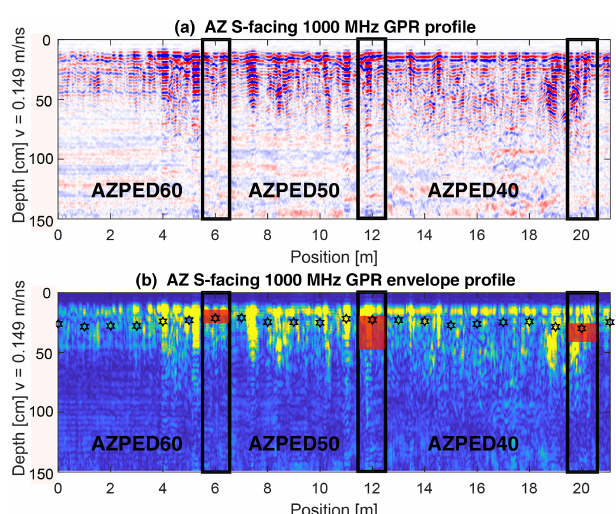
Figure 12. (a) 1000MHz GPR transect and (b) envelope for the S- facing hillslope in Pan de Azúcar. The hillslope transect spans over ∼ 20m and includes pedon AZPED60, AZPED50, and AZPED40 (black boxes). The potential pedolith thickness based on the en- velopes is indicated by stars (in b ). The red bar indicates the B to C horizon transition as given in Bernhard et al. (2018). Uphill is from left to right. Note that in the radar data the air wave and background removal is